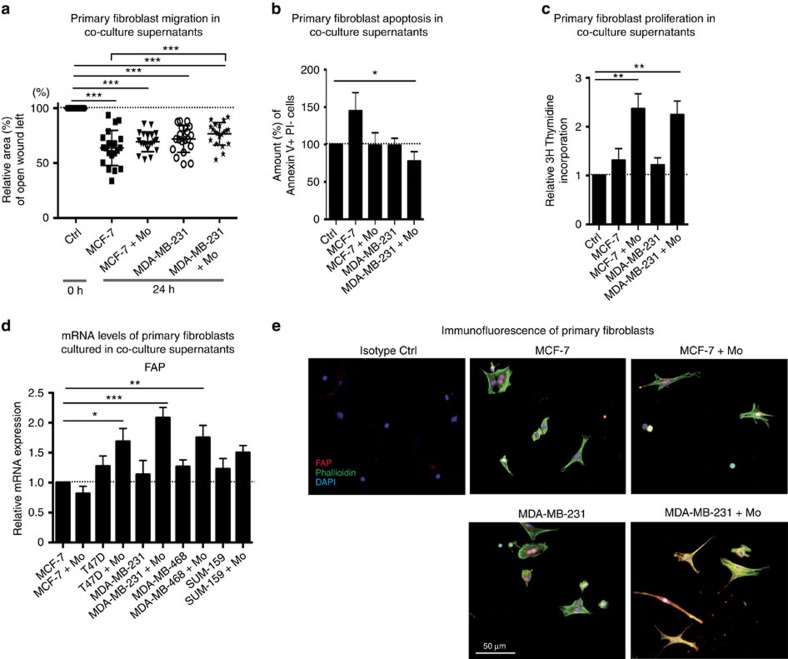
Characterization of primary fibroblasts in TNBC cultures.Primary mouse fibroblasts are activated by monocytes in the TNBC context in vitro. (a) Scratch wound assays showing mouse primary fibroblast migration in supernatants derived from co-cultures of human primary monocytes (Mo) and luminal A (MCF-7) or TN (MDA-MB-231) breast cancer cells. ***=P<0.001 ANOVA non-parametric Kruskal–Wallis test. N=20. (b) Survival analysis of mouse primary fibroblast grown in supernatants derived from co-cultures of human primary monocytes and luminal A (MCF-7) or TN (MDA-MB-231) breast cancer cells. Annexin V staining was used to analyse the percentage of apoptotic cells. *=P<0.05 ANOVA. N=10. (c) Proliferation of mouse primary fibroblasts grown in supernatants derived from co-cultures of human primary monocytes and luminal A (MCF-7) or TN (MDA-MB-231) breast cancer cells, measured using a thymidine incorporation proliferation assay. **=P<0.01. ANOVA Dunnett's multiple comparison test. N=14. (d) mRNA expression levels of FAP in mouse primary fibroblasts cultured in supernatants derived from co-cultures of human primary monocytes and luminal A (MCF-7 and T47D) or TN (MDA-MB-231, MDA-MB-468 and SUM-159) breast cancer cells, assessed by RT-QPCR analysis. *=P<0.05 **=P<0.01 ***=P<0.001 ANOVA Dunnett's multiple comparison test. N=4. (e) Immunofluorescence of anti-fibroblast activation protein (FAP; red), phalloidin to stain actin filaments (green) and DAPI (nuclear stain; blue) in primary mouse fibroblasts cultured in supernatants derived from co-cultures of primary human monocytes and luminal A (MCF-7) or TN (MDA-MB-231) breast cancer cells. Scale bar represents 50 μm. Error bars indicate s.e.m.